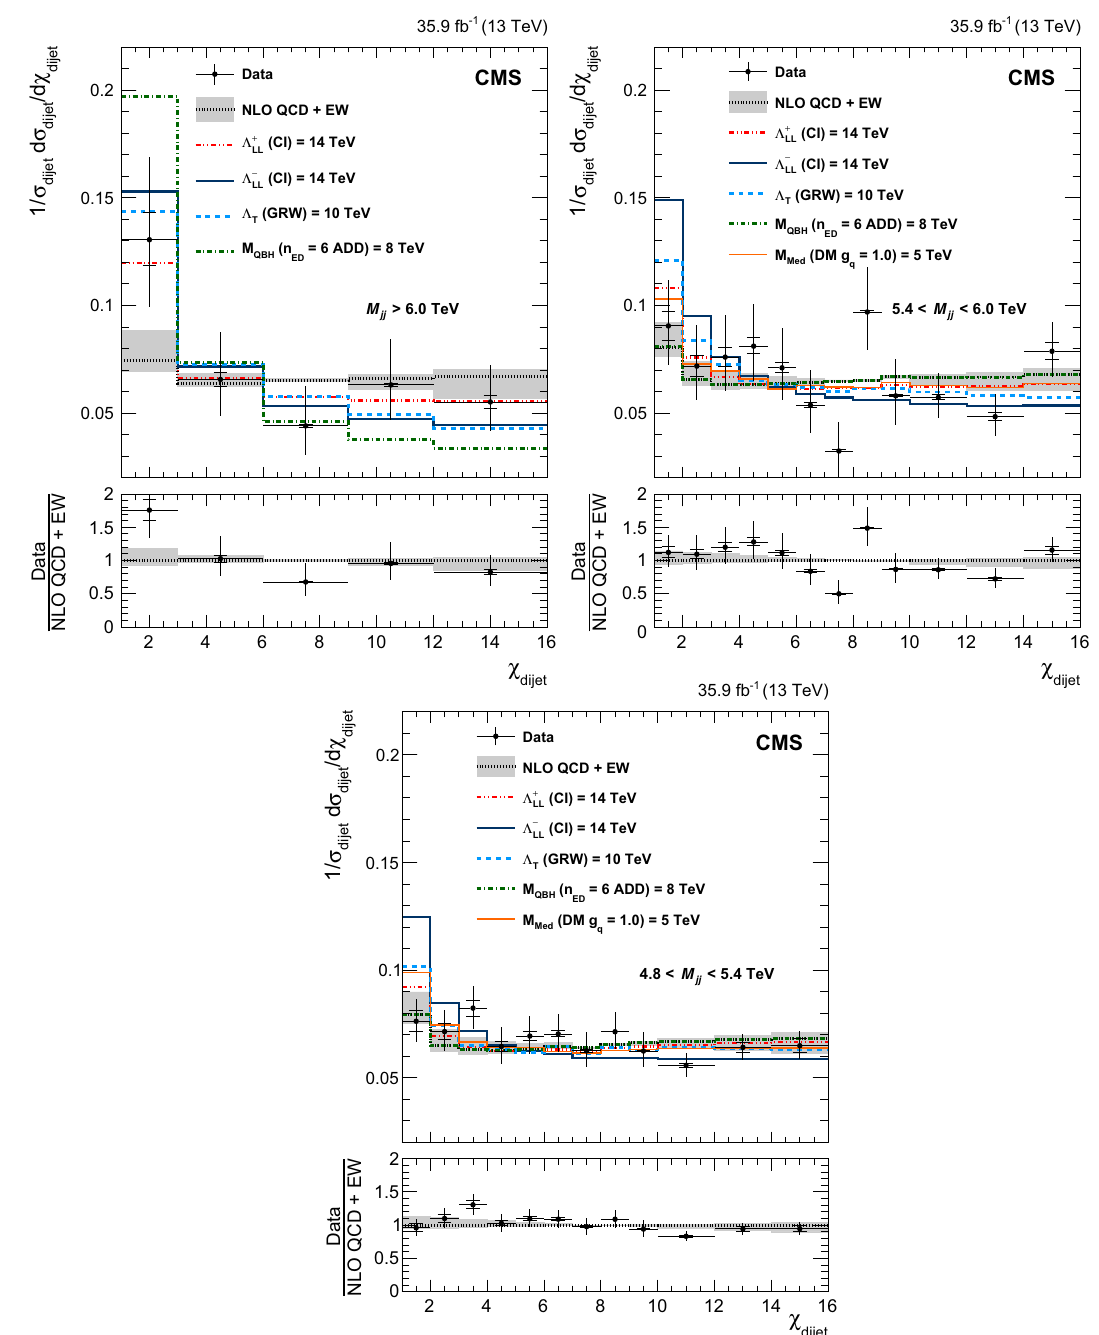
Fig. 1 Normalized χ dijet distributions in the three highest mass bins. Unfolded data are compared to NLO predictions (black dotted line). The error bars represent statistical and experimental systematic uncer- tainties combined in quadrature. The ticks on the error bars correspond